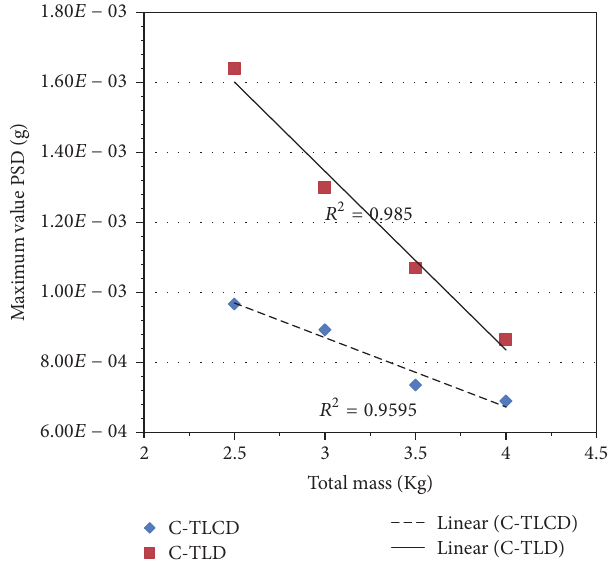
Figure 11: Maximum values of PSD versus total mass of water and device for C-TLD and C-TLCD passive